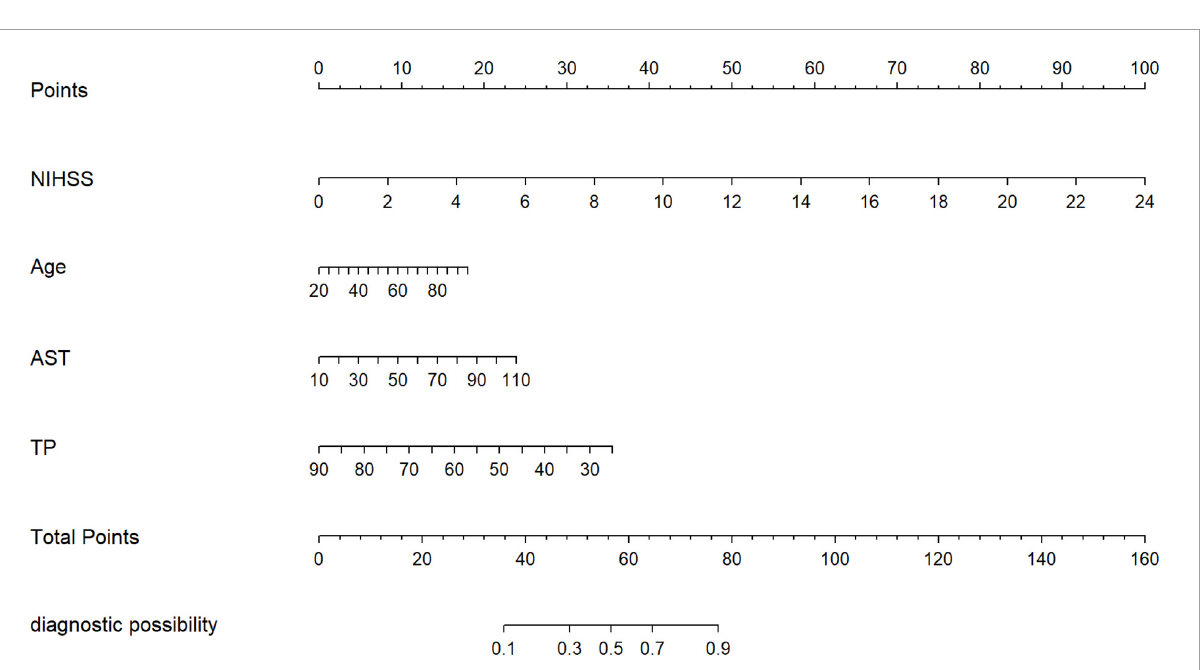
functional outcomes at 3-month follow-up was 0.8753, which showed good discrimination ( Supplementary Figure 2 ). In the validation group, we discovered that the AUCs of the three ROCs reached 0.8511, 0.8306, and 0.8176, respectively. What is